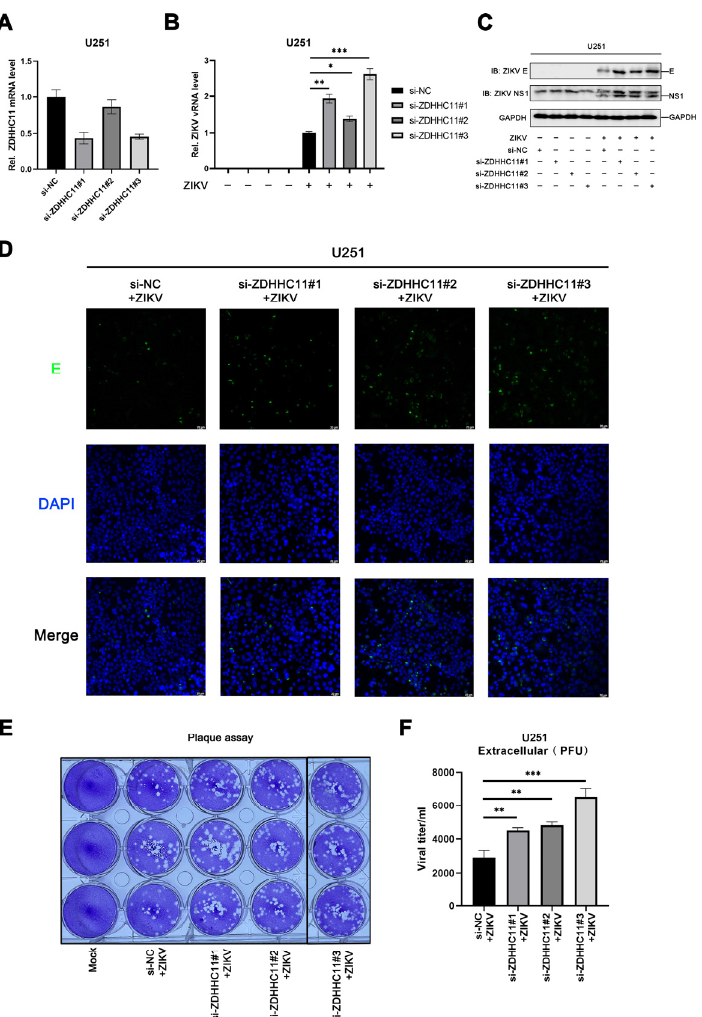
Figure 6. ZDHHC11 knockdown enhances ZIKV infection. U251 cells were transfected with anti- ZDHHC11 siRNA or the negative control, and subsequently infected with ZIKV (MOI = 1) using incubation for 24 h. The mRNA levels of ( A ) ZDHHC11 and ( B ) viral RNA were measured with quantitative PCR. The abundance of viral proteins was detected with ( C ) immunoblotting and ( D ) CLSM. ( E , F ) The ZIKV titer in the supernatants was calculated using plaque assays. (*, p < 0.05; **, p < 0.01; ***, p < 0.001).